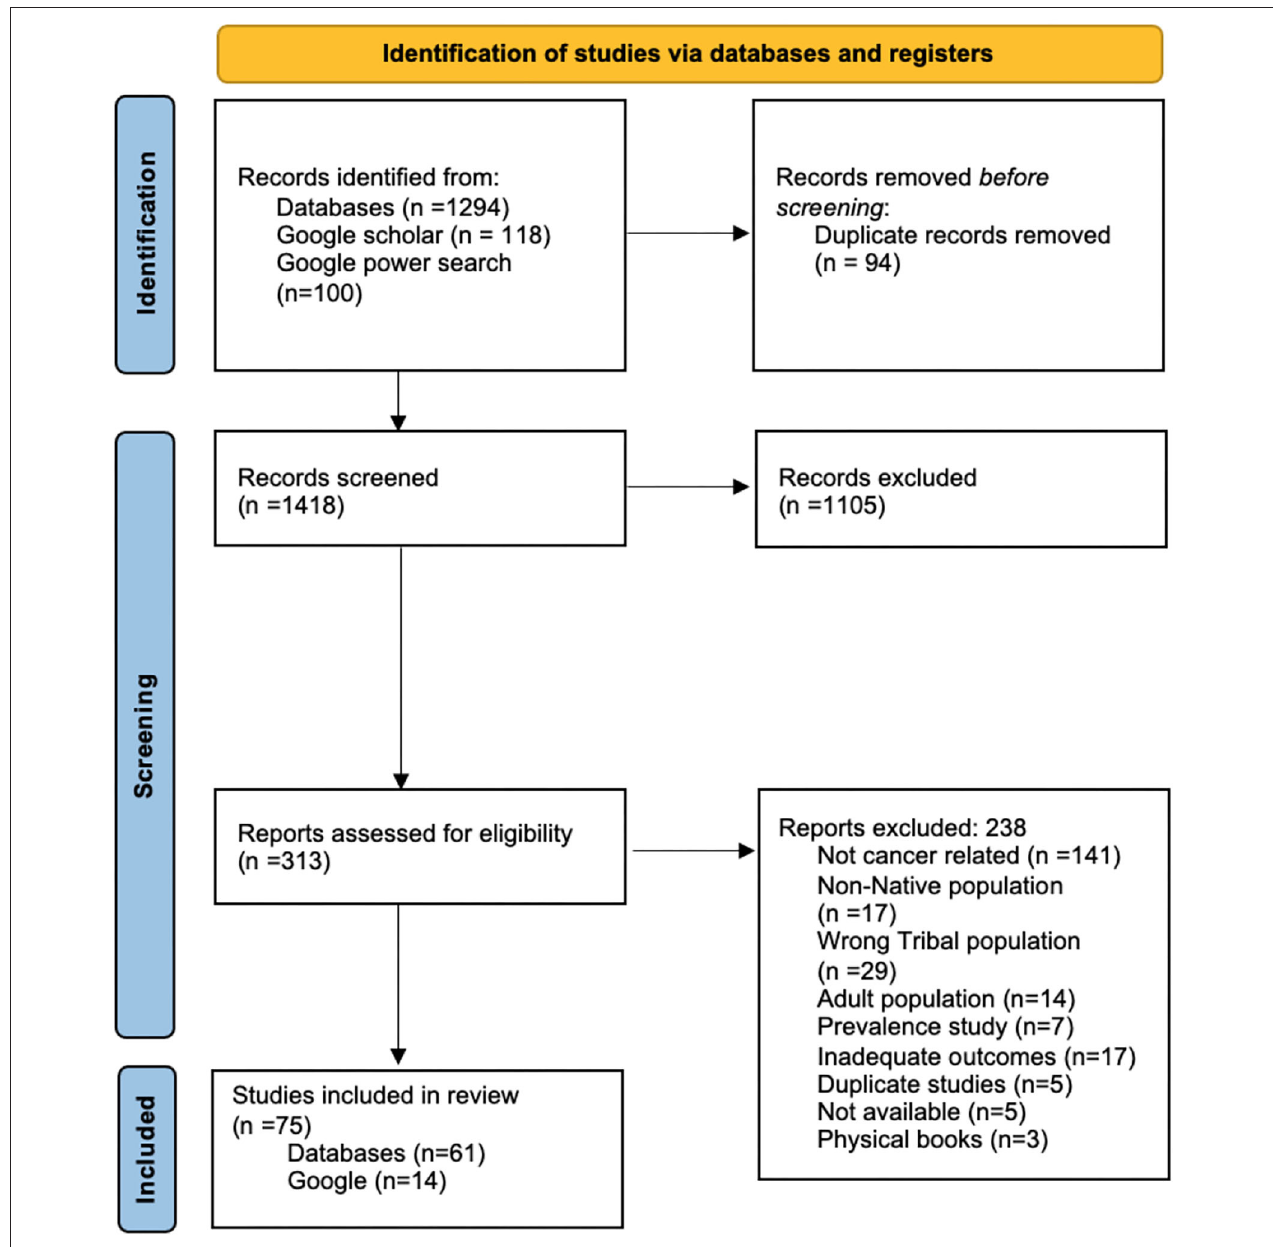
FIGURE 2 | PRISMA